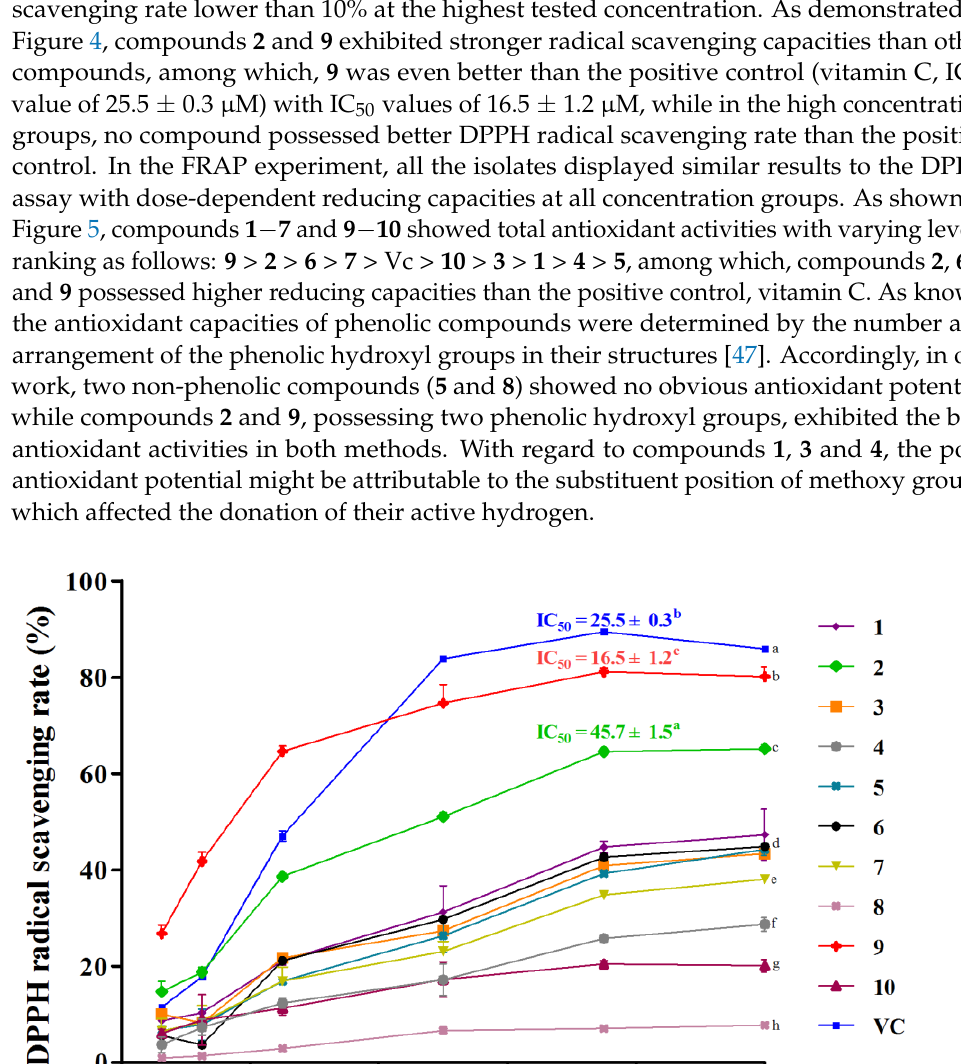
Figure 5. Total antioxidant activities of compounds 1 − 7 and 9 − 10 by FRAP assays. VC was used as positive control. Compound 8 did not show any activities in FRAP assay. Data are expressed as means ± SD ( n = 3). Means labeled by different letters (a – e) were significantly different at a level of p < 0.05 ( n = 3) by One-Way ANOVA DMRT. 3.5. COX-2 Inhibition Activity Assays of Isolated Compounds The anti-inflammatory activities of all the compounds was also evaluated by the COX-2 inhibitor screening method, with final concentrations ranging from 0.04 to 25 µM. As displayed in Figure 6, compounds 1 − 7 and 9 − 10 showed COX-2 inhibition capacities